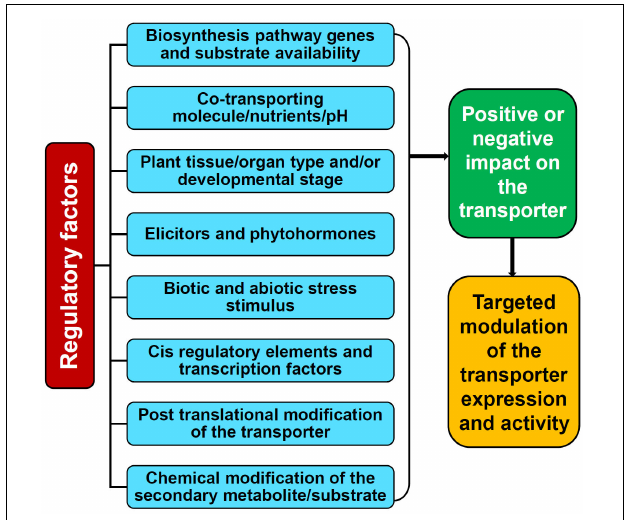
FIGURE 2 | Factors affecting the activity and function of the plant secondary metabolite